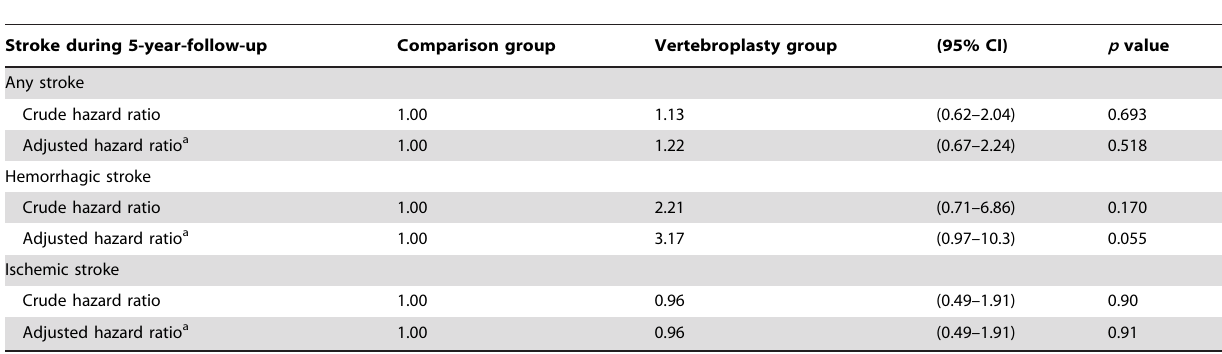
Table 3. Hazard ratios of subsequent strokes post-vertebroplasty (2004.1.1–2008.12.31, n